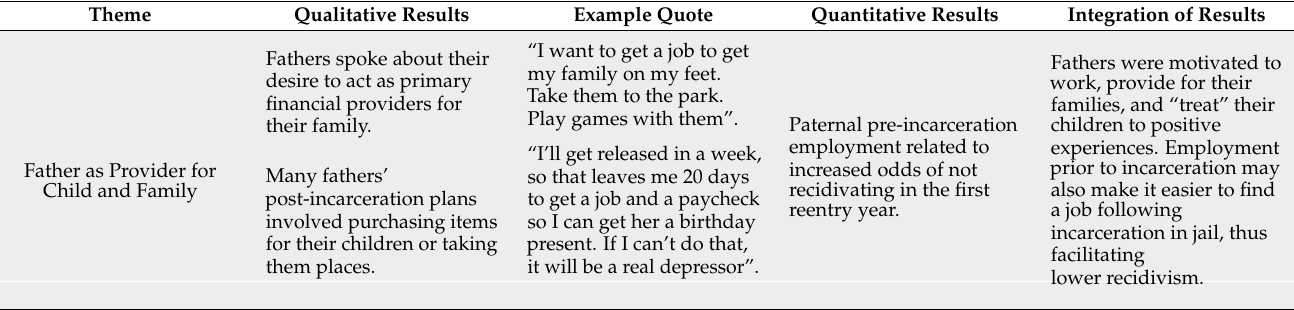
Table 3. Integrated Results Matrix for Qualitative and Quantitative